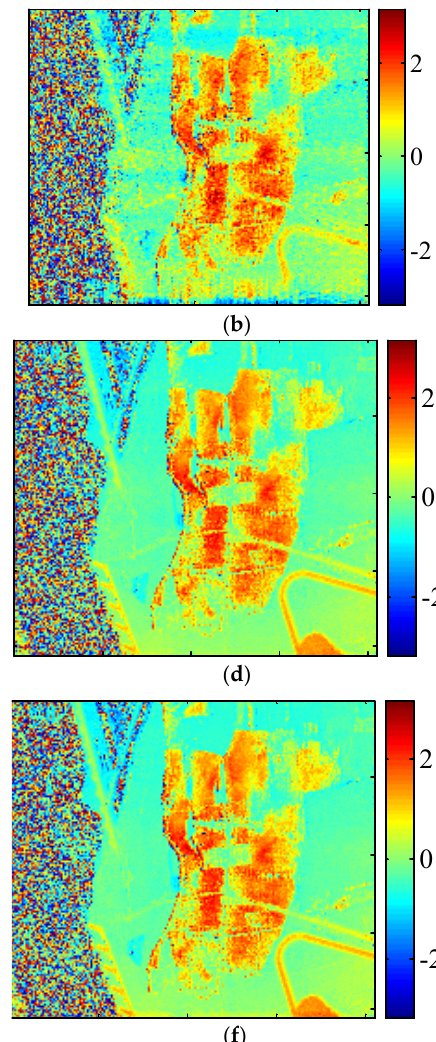
( d ) Figure 7. Amplitudes of PolInCCs for different sub-views of the HV channel. ( a ) amplitude of PolInCCs for sub-view 1, ( b ) amplitude of PolInCCs for sub-view 2, ( c ) amplitude of PolInCCs for sub-view 3, and ( d ) statistical curve of PolInCCs’ amplitudes in different sub-images. To examine the relationship between the forest and the scattering phase, the inter- ferometric phase images of different sub-views of HV channel images were obtained from the complex PolInCCs. Before this operation, one of the most significant steps was to calibrate the attitude error, mainly caused by the roll angle, in terms of the inertial navigation system (INS). Without this procedure, the interferometric phase fringe would be severely bent, although the ground in the forest area is flat, thus resulting in great er- rors in the final forest height estimation. After the attitude calibration, the interferomet- ric phase fringe of the sub-views images was nearly straight along the azimuth in the images in terms of the flat ground context. Figure 8 shows the phase fringes of different sub-views of the HV channel, and the phase results of different sub-views obtained after removing the flatting effect. Based on the phase fringe maps, we can see that, on the left side of the map, the phase was almost noise. Because the scene on the left side was the yellow river, the decorrelation effect was very remarkable in the torrents.